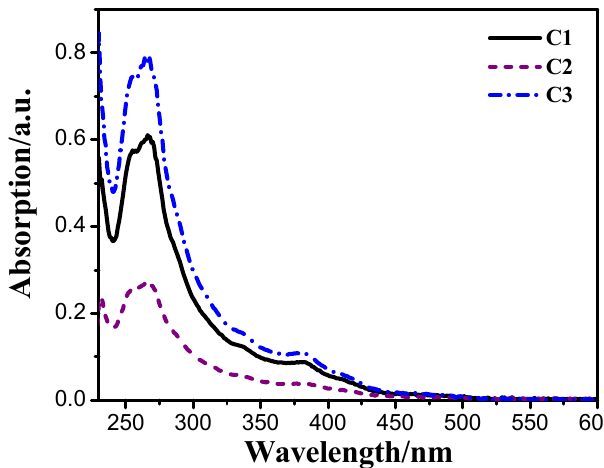
Figure 2. UV-Vis absorption spectra of the cationic iridium(III) complexes in CH 2 Cl 2 at 1.0 × 10 − 5 mol·L − 1 at room temperature.